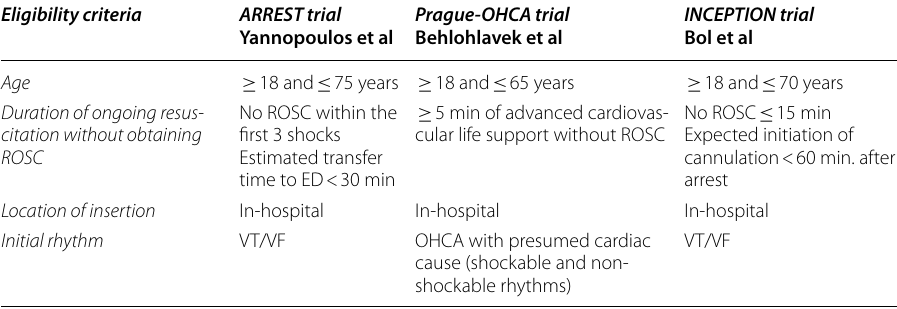
ED emergency department, ROSC return of spontaneous circulation, VT ventricular tachycardia, VF ventricular